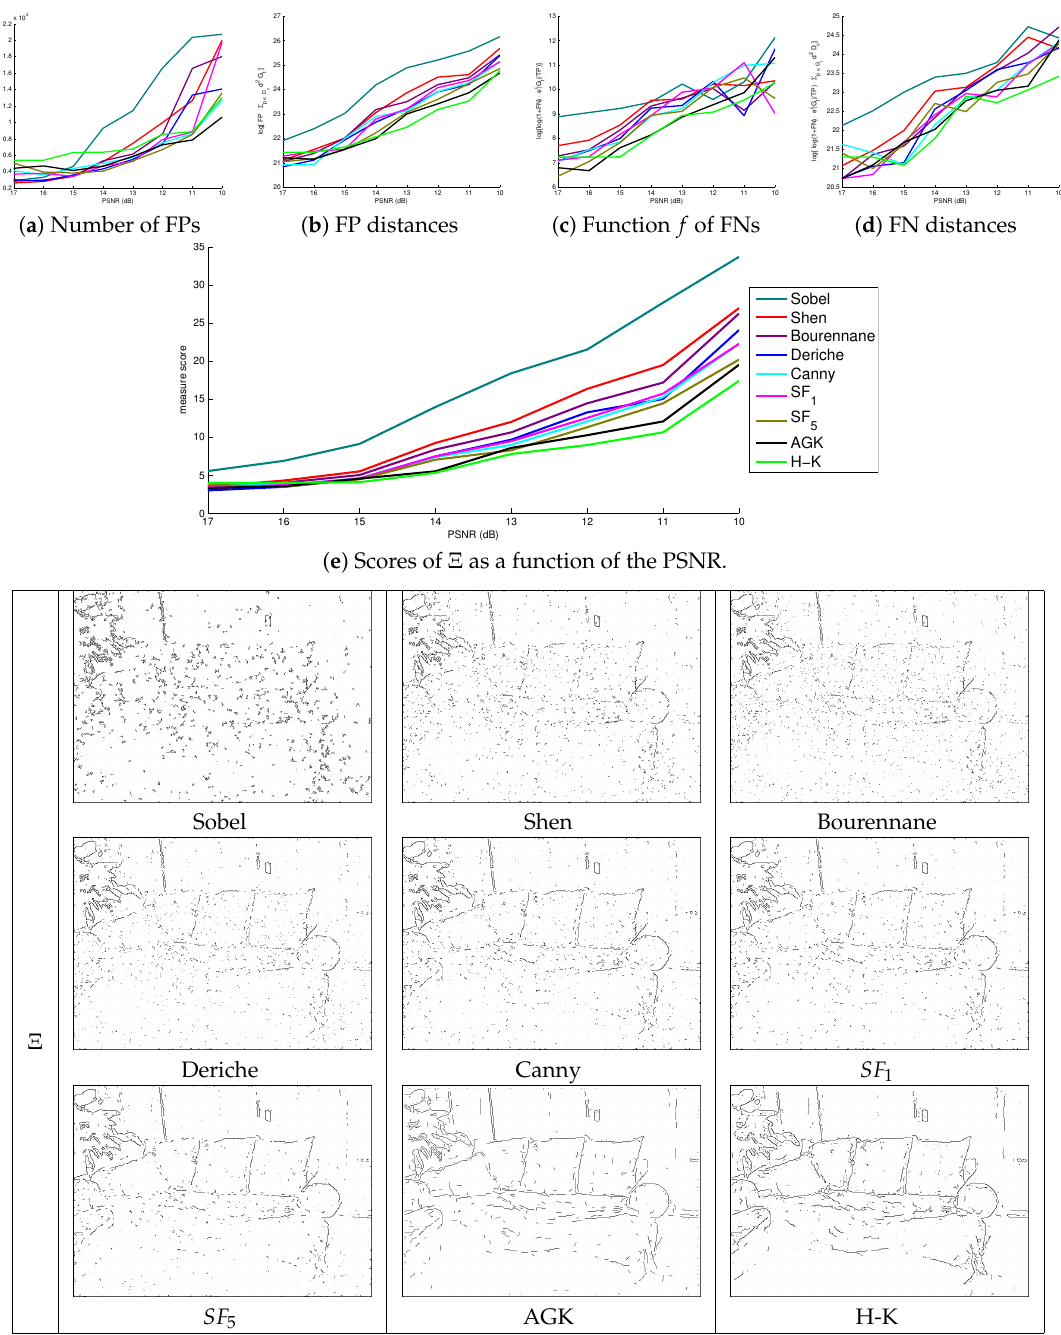
Figure 48. Segmentations and scores concerning Ξ measure and image